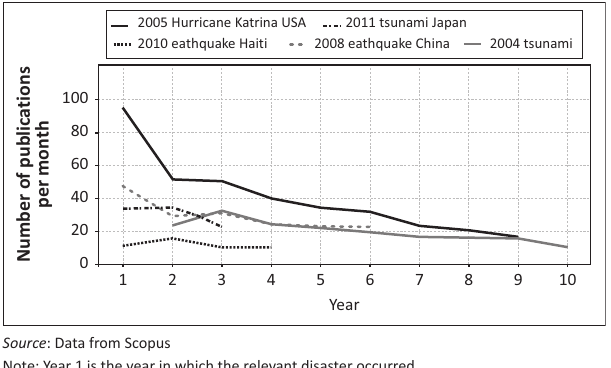
FIGURE 1: Average number of publications per month after selected major disasters between 2004 and